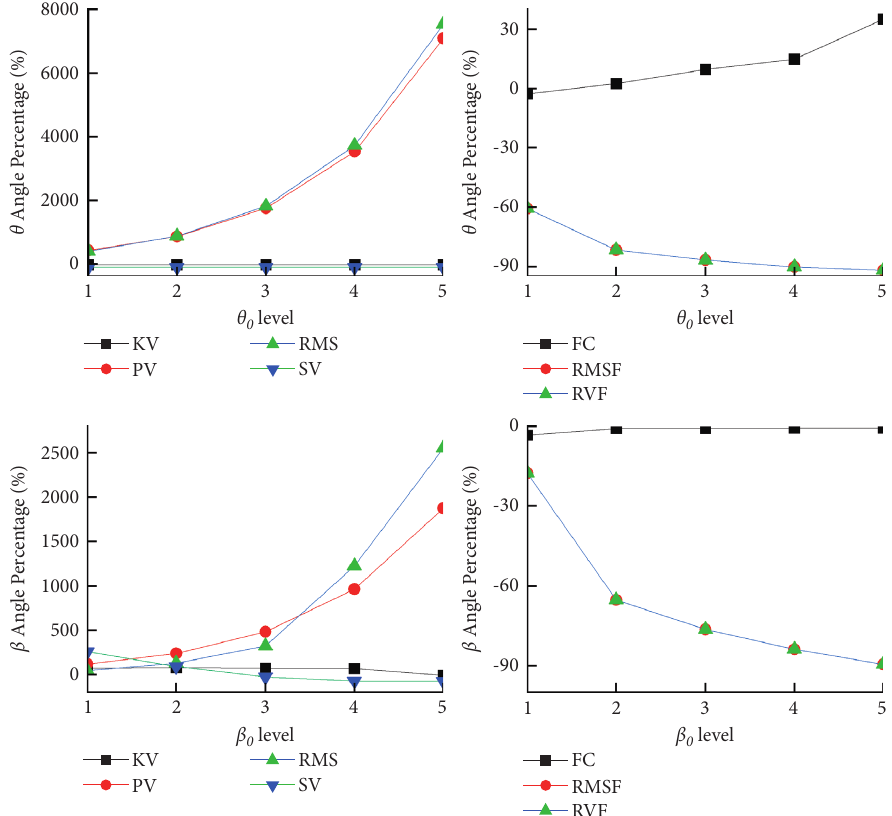
Figure 17: Effect of the initial angles on the lift-slewing